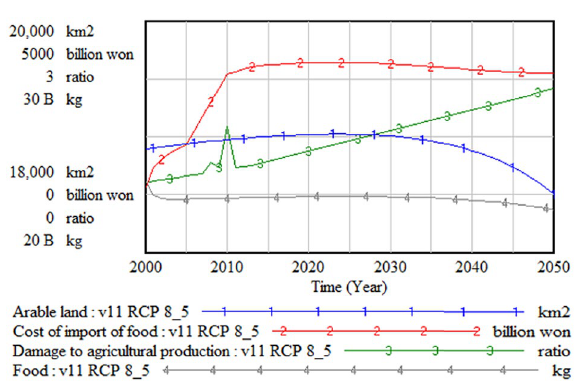
Figure 10. Arable land and food.